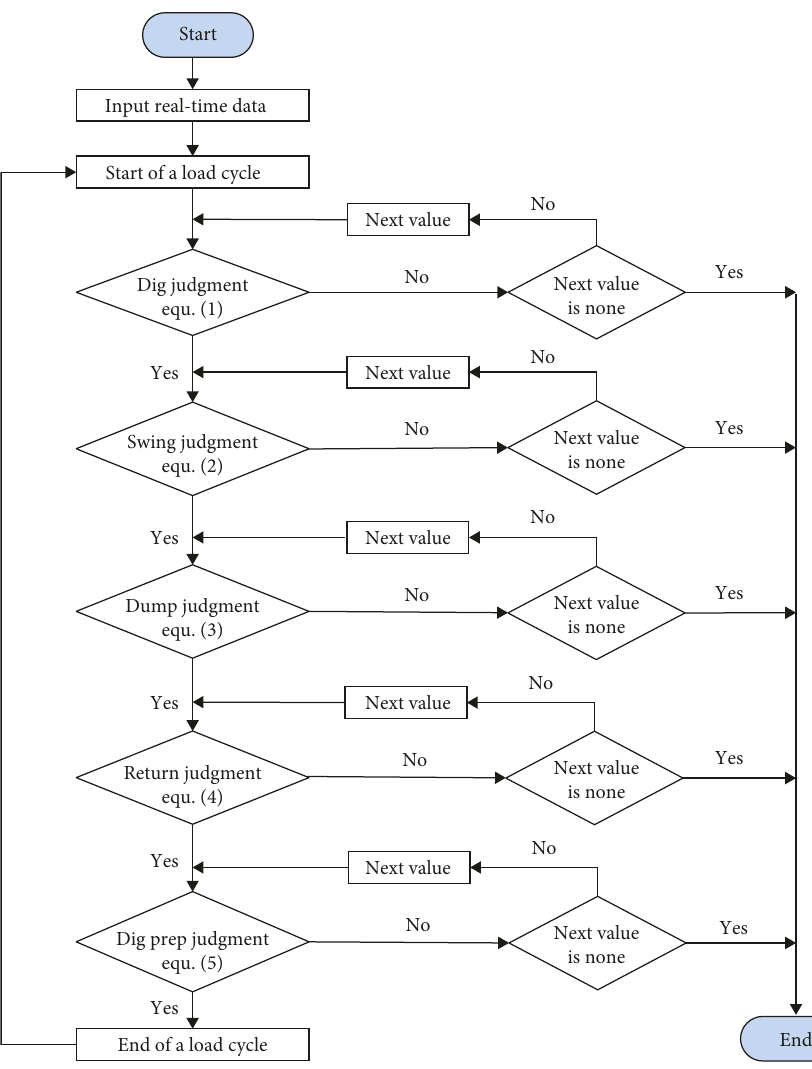
Figure 4: Logical diagram of recognition algorithm for loading cycle operation. Table 2: Working cycle algorithm input